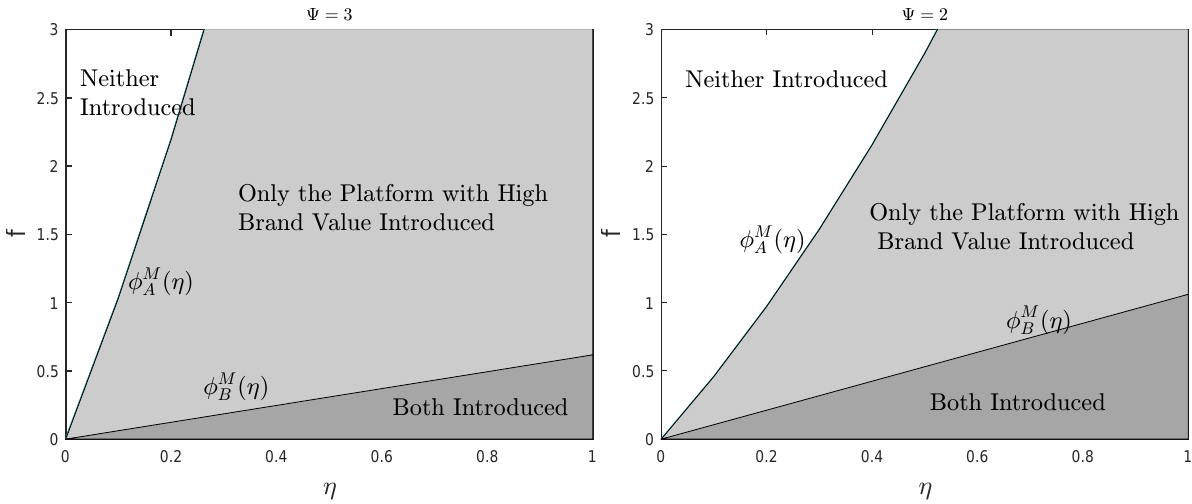
Figure 6. Equilibrium Strategy in Single-homing Markets.